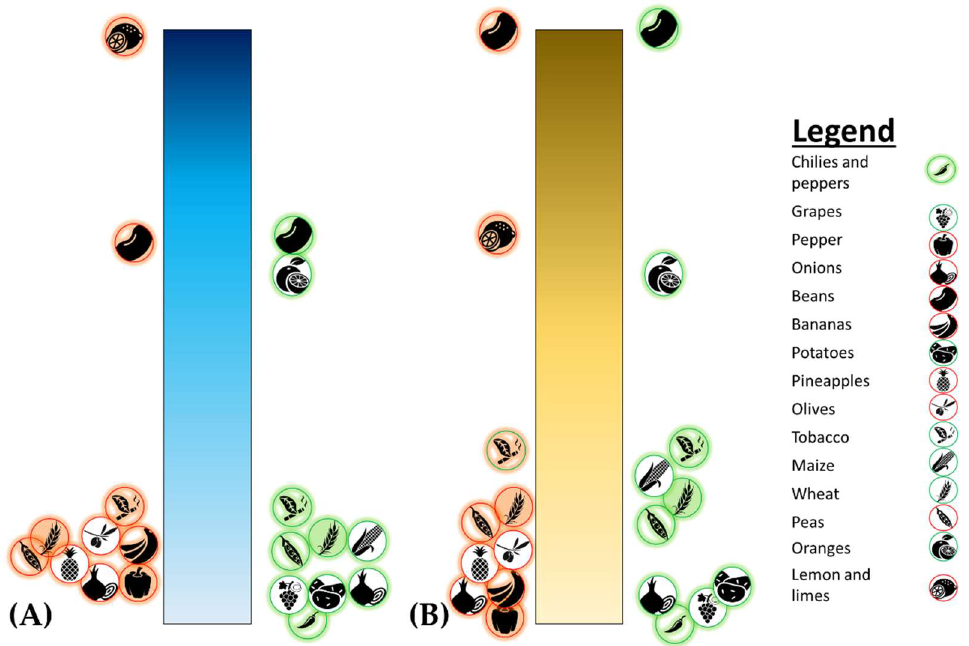
Figure 18. Embodied virtual quantities normalized for the top trade crops: ( A ) shows the water contents ranging from zero to one (bottom to top), whereas ( B ) shows the land contents. The green glow shows the imports; the red glow shows exports.